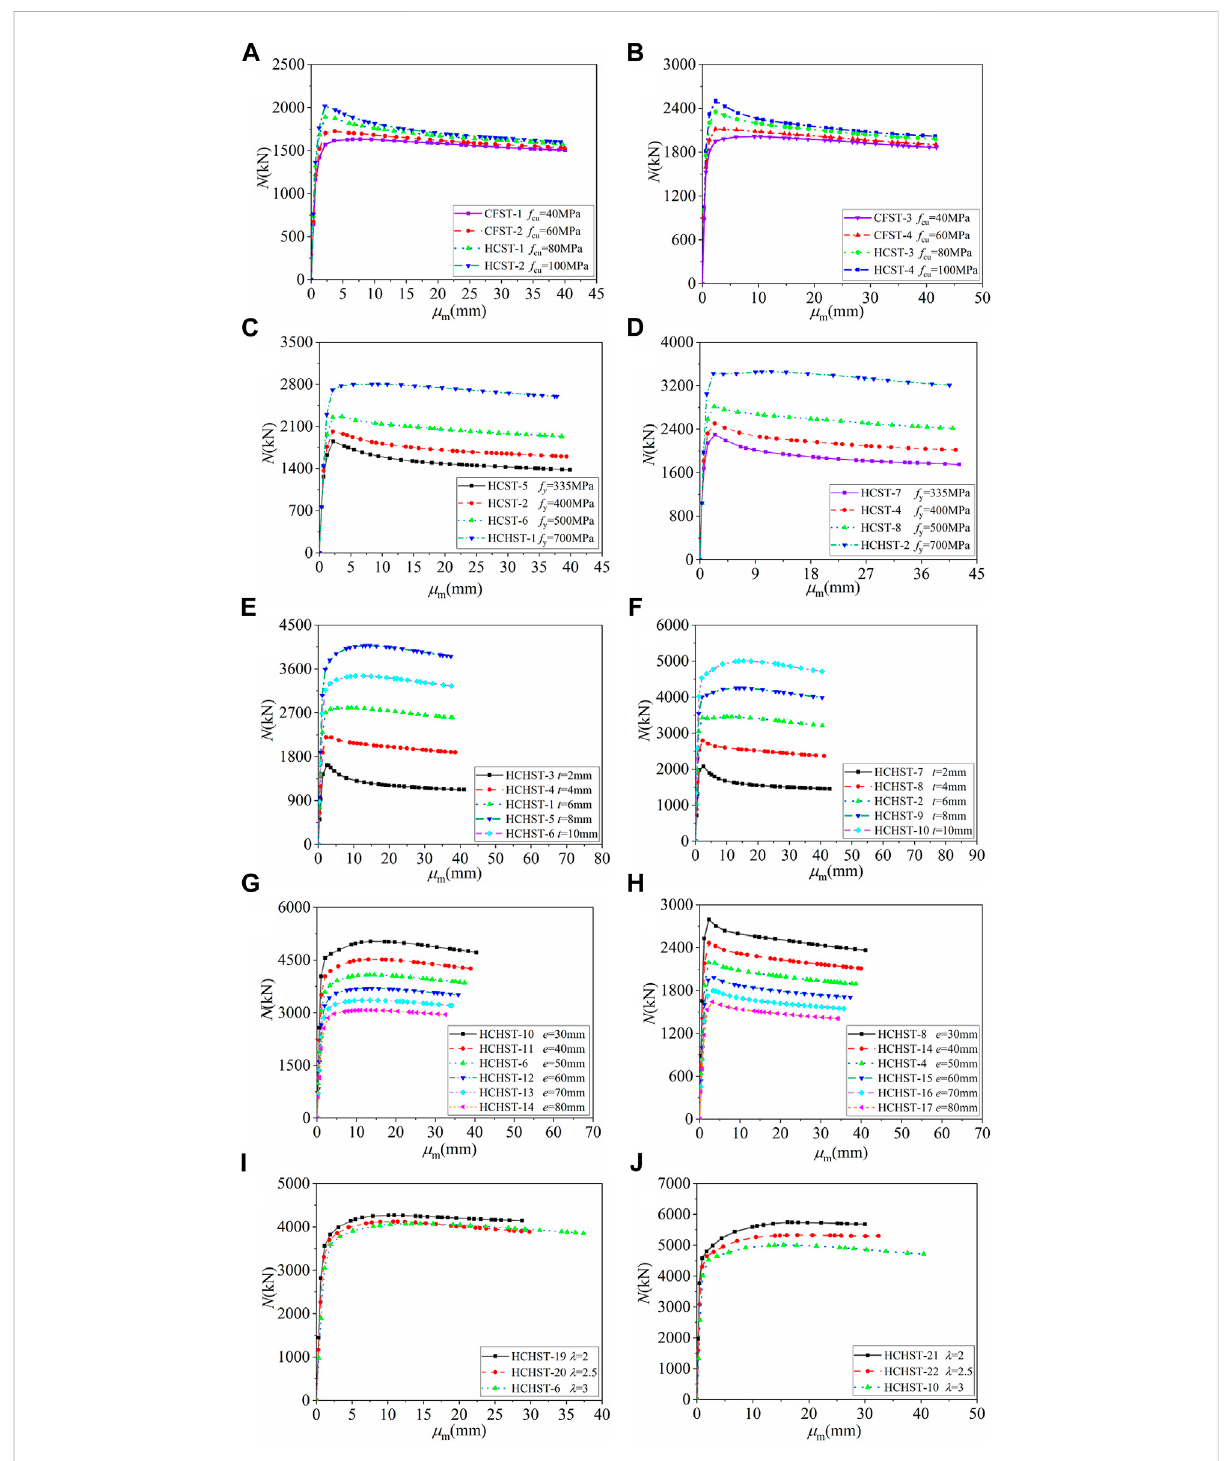
FIGURE 6 ComparisonofN- μ m curveswithdifferentparameters. (A) Differentf cu when e =30 mm; (B) Differentf cu when e =50 mm; (C) Differentf y when e = 30 mm; (D) Different f e = 50 mm; (E) Different t when e = 30 mm; (F) Different t when e = 50 mm; (G) Different e when t = 4 mm; (H) y when Different e when t = 10 mm; (I) Different λ when e = 30 mm; (J) Different λ when e = 50